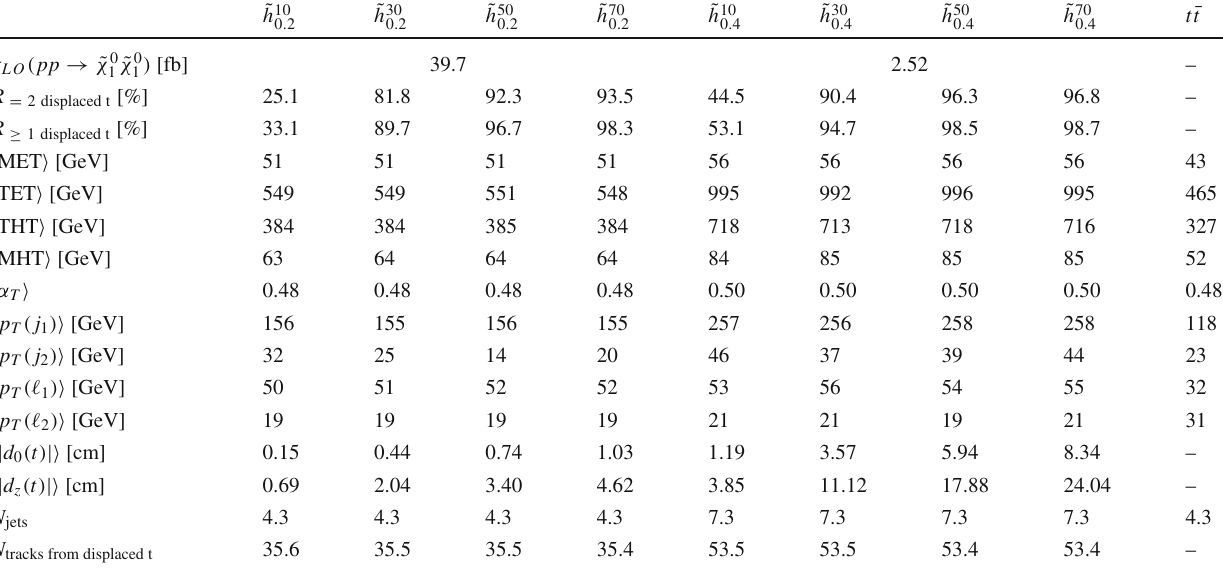
Table 4 Mean values of some observables and number of events with top quarks decaying in the tracker volume for the eight benchmarks in the higgsino ˜ h 2 case. We remind that R ≥ 1 displaced t corresponds to the number of events with at least one top quark decaying in the tracker